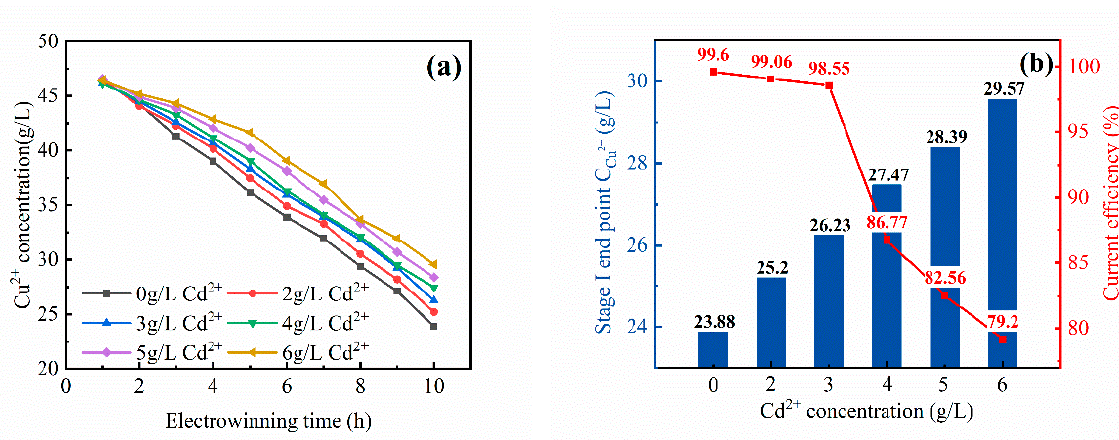
Figure 5. The curve of Cu concentration, endpoint content, and current efficiency in the first stage of the cyclone electrowinning process: ( a ) Cu concentration; ( b ) Endpoint content and current efficiency. Table 1. Copper purity of cathode with different Cd 2+ concentrations in the first stage.